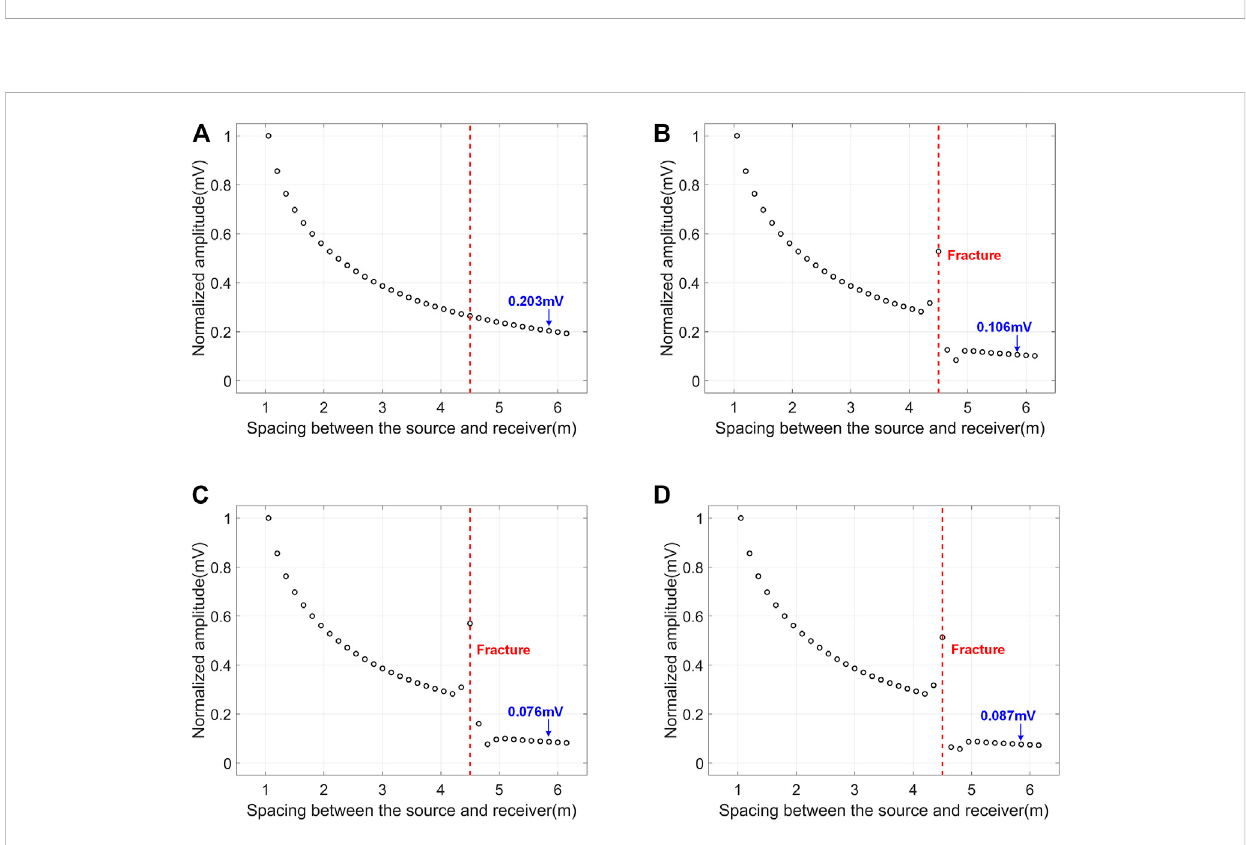
FIGURE 13 Normalized amplitude of monopole P wave versus source-receiver spacing. The fracture dip angle is 90 ° and fi lled with water. (A) No fracture; (B) 10 mm width fracture; (C) 20 mm width fracture; (D) 40 mm width fracture.